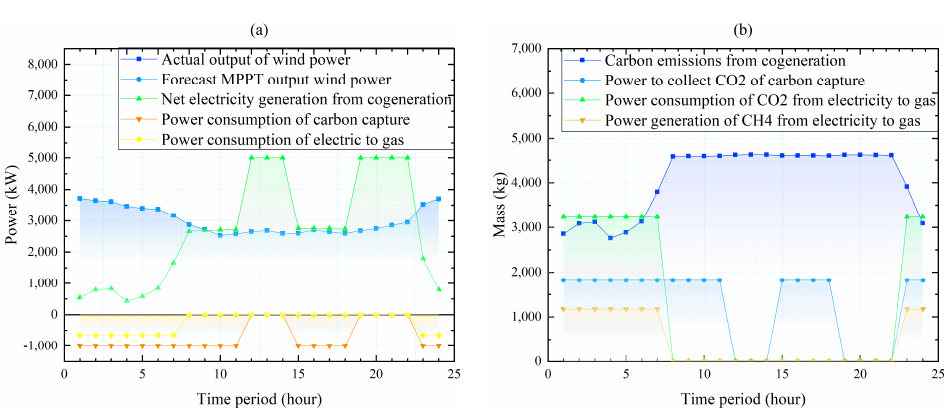
Figure 4. Micro−grid 2 introduces P2G low−carbon operation electric carbon power. (a) Electric power of micro−grid 2. (b) Carbon power of micro−grid 2. power of micro − grid 2. ( b ) Carbon power of micro − grid